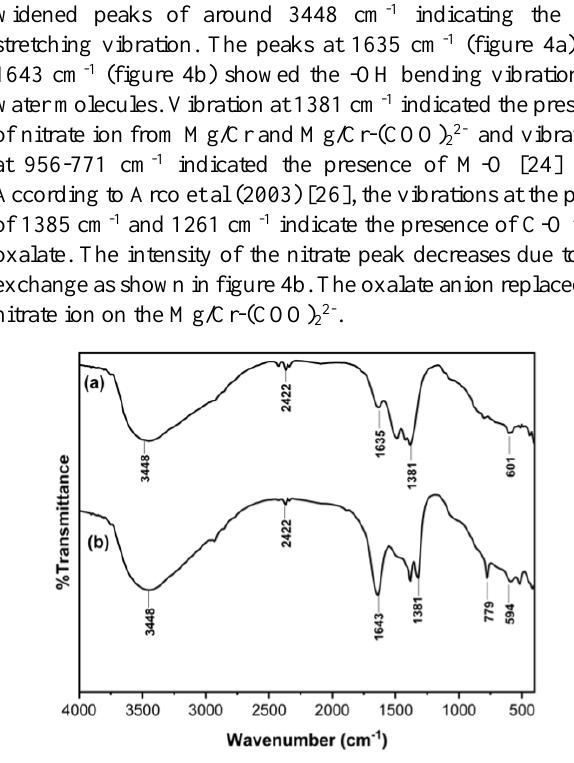
Fig. 4. FT-IR Spectrum of Mg/Cr (a) and Mg/Cr-(COO) 22- LDH